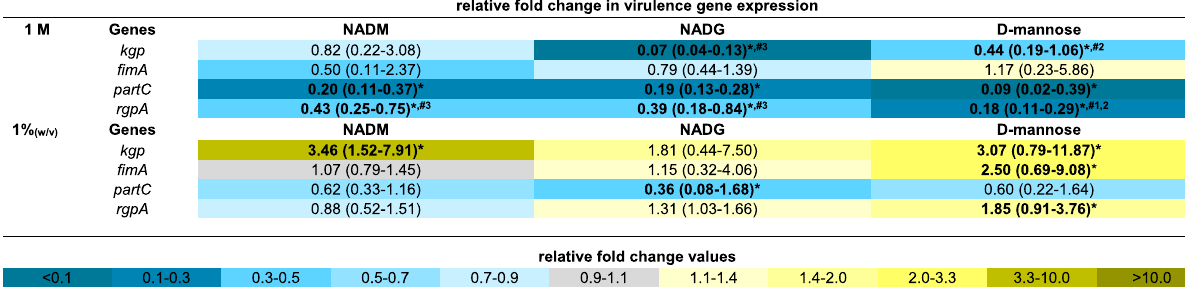
Table 2. Comparison of the effects of repeated multi-species biofilm rinsing with NADM, NADG or d-(+)- mannose on P. gingivalis virulence gene expression. Fold changes in virulence gene expression were determined relative to the control condition through the 2 −ΔΔCt method and are shown as the geometric mean (C.I.) (n = 3) of the 2 −ΔΔCt values. All substrates were dissolved in PBS at 1 M (upper part) or ~ 0.05 M (1% (w/v) ) (lower part) (0.045 M (NADM and NADG) and 0.056 M (d-(+)-mannose)). Values between 0 and 1 represent relative downregulation, values > 1 represent relative upregulation. Statistically significantly different fold changes relative to the control (PBS) that are < 0.5 (> twofold downregulated) or > 1.5 (> 1.5-fold upregulated) are considered biologically relevant and are shown in bold and marked with ‘ * ’ ( P < 0.05, ANOVA + Dunnett’s correction for simultaneous hypothesis testing). For such values, statistically significant differences between two treatment conditions are marked with ‘ #1 ’ (vs. NADM), ‘ #2 ’ (vs. NADG), ‘ #3 ’ (vs. d-(+)-mannose) and shown in bold ( P < 0.05, ANOVA + Tukey’s correction for simultaneous hypothesis testing for comparisons between 3 substrates, unpaired two-tailed t-test for comparisons between 2 substrates). Statistically significantly different values between treatment conditions were only considered relevant if each condition was also significantly different from the control condition and only such differences are indicated. Color code: magnitude of the fold change in gene expression relative to the control. NADM: N -acetyl-d-mannosamine; NADG: N -acetyl-d- glucosamine; C.I.: 95% confidence interval.